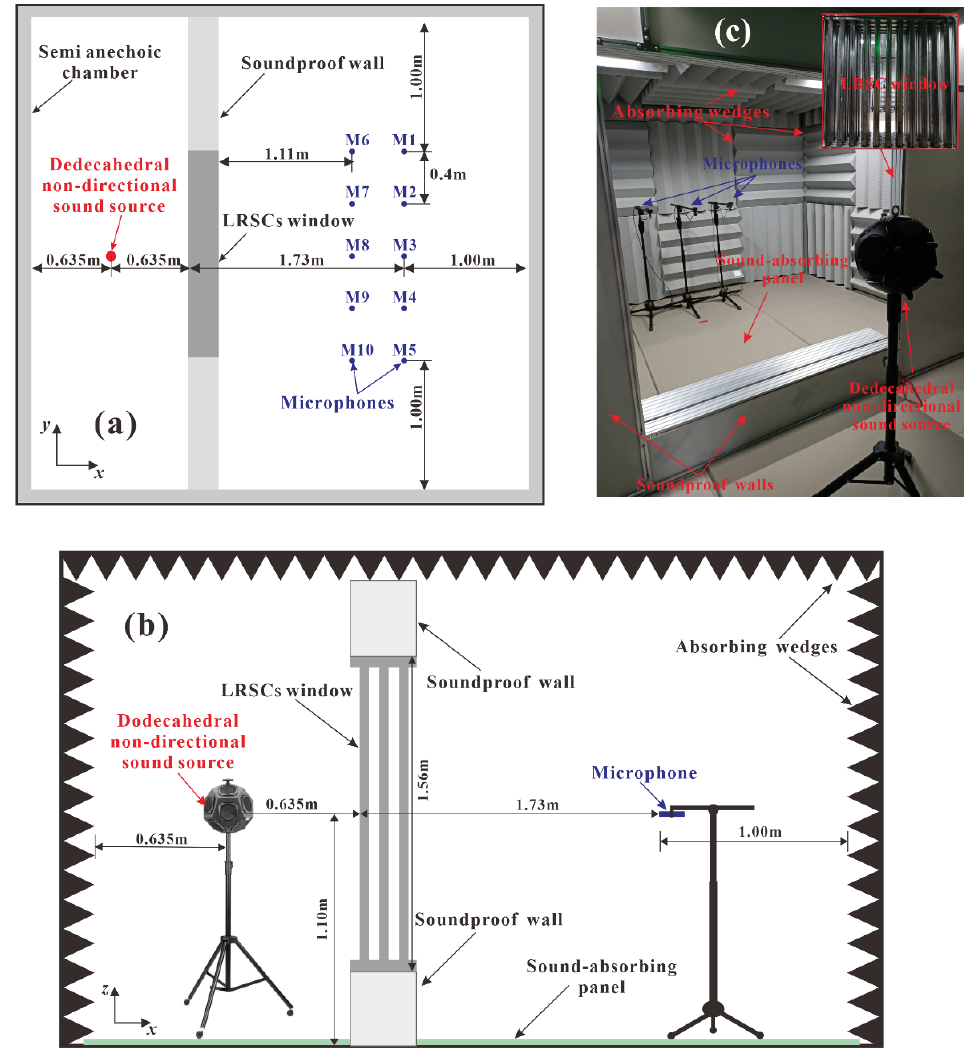
Figure 6. Experimental setup in the semi-anechoic chamber: ( a ) schematic of top view, ( b ) schematic of side view, ( c ) onsite experimental conditions.